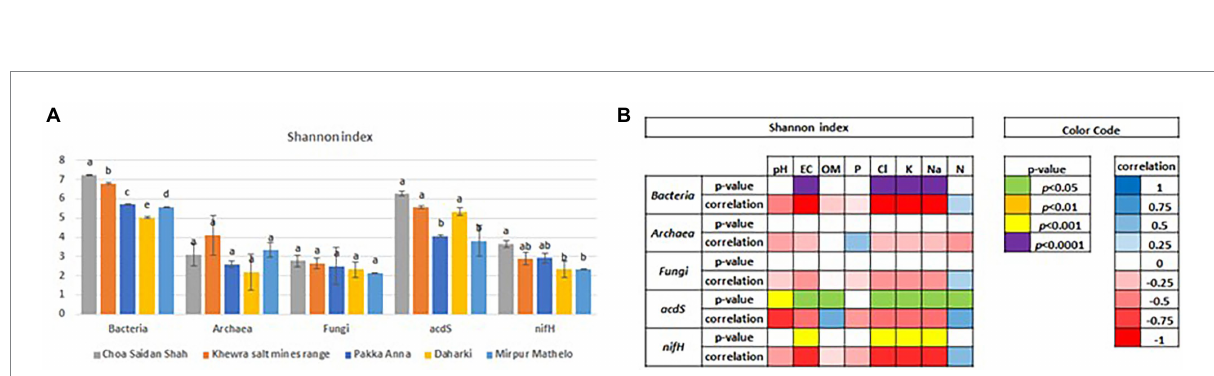
FIGURE 2 Differences in the alpha diversity of soil microbial communities in five soils collected from agricultural fields within the Indus River Basin, Pakistan, calculated using the Shannon Index ( p < 0.05) (A) , and Pearson’s ρ correlations between the Shannon index and select soil chemical properties (B) . EC, Electric conductivity; OM, total organic matter; P, exchangeable phosphorous; CL, total concentrations of chloride; K, potassium; Na, sodium; N,